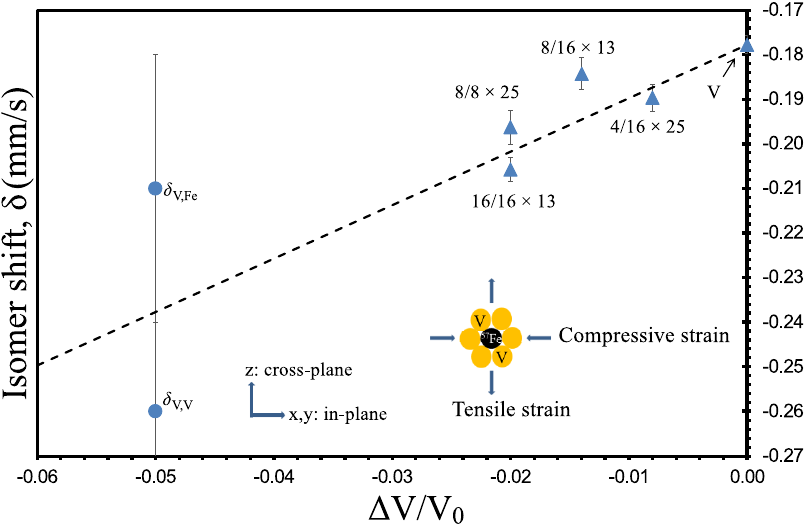
Figure 9. Plot of the isomer shift of the Fe atoms in pure vanadium foil as a function of the volume compression ( ∆ V / V 0 ) adapted with permission from [34] as compared to the measured isomer shifts of the Fe V component ( δ Fe ) from our work. Blue triangles are the measured δ Fe values from the Fe/V V V superlattice and pure V − layer as indicated. Dashed line is defined by ∆ δ / ∆ ( V / V 0 ) = 1.2 mm/s adapted with permission from [34]. Copyrighted by the American Physical Society. The blue dots are the estimated isomer shifts for the 8/8 × 25 sample by Equations (4) ( δ V . Fe ) and (5) ( δ V . V ), respectively. A negative ∆ V / V 0 indicates a compression and a positive ∆ V / V 0 an expansion (tensile strain) of the V − lattice